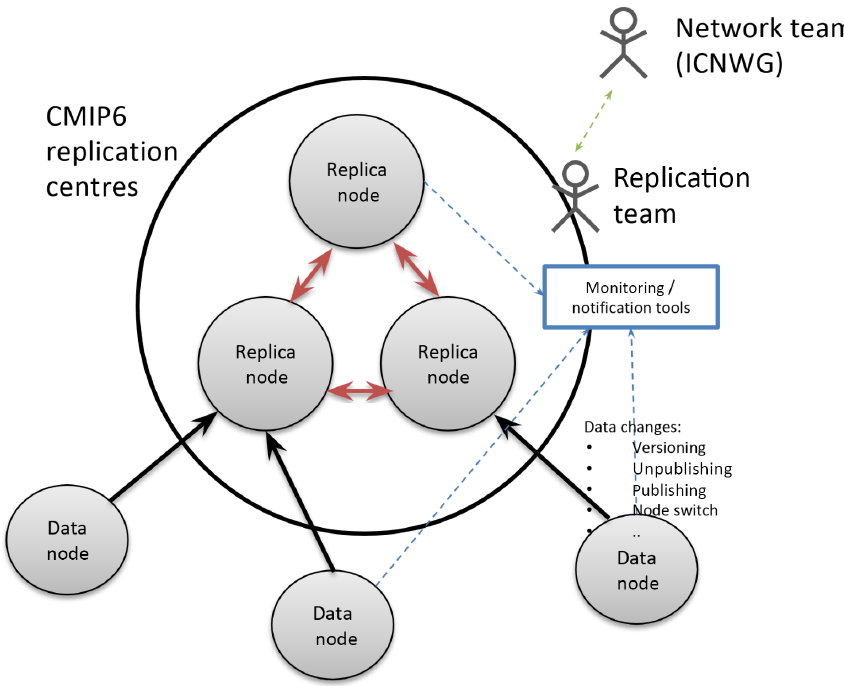
Figure 7. CMIP6 replication from data nodes to replica centres and between replica centres coordinated by a CMIP6 replication team, under the guidance of the